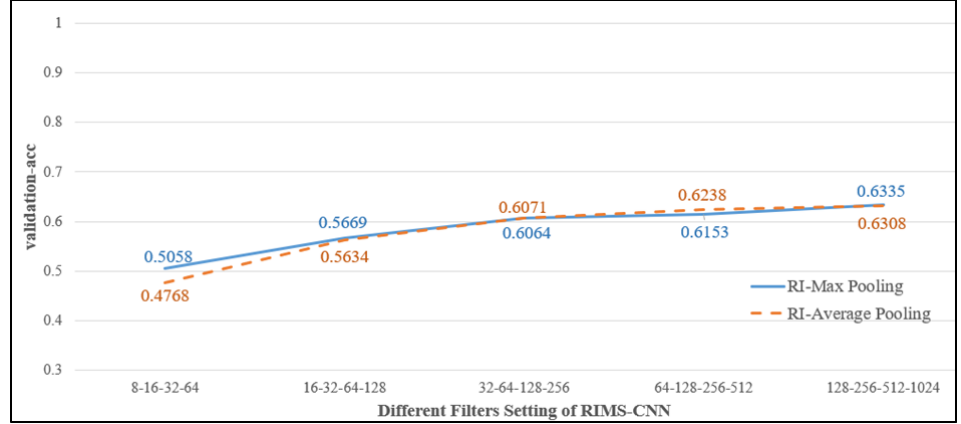
Figure 19. Comparing RI-max pooling with RI-average pooling on the fixed-angle rotated CIFAR-100.